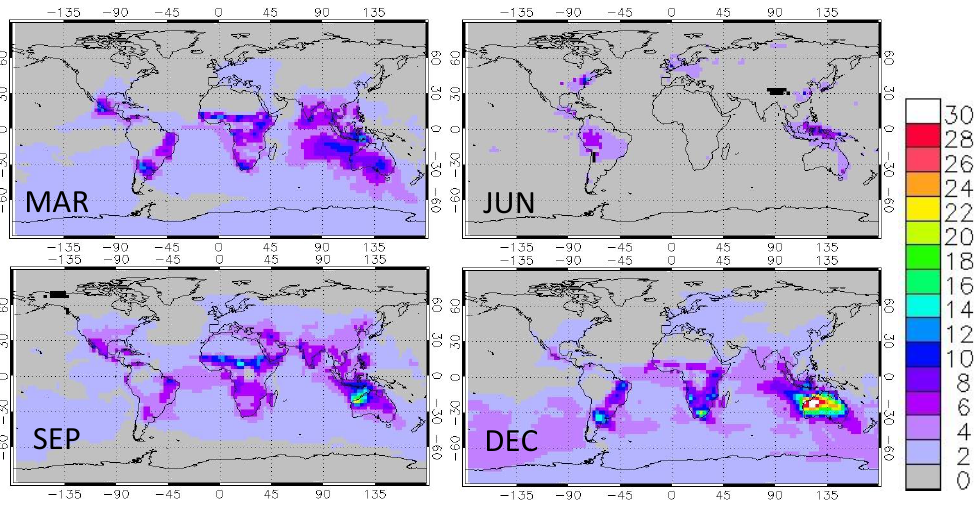
Fig. 4. Fractional change in simulated surface SOA concentrations due to 2p parameter updates and consideration of additional SOA precursors (MZ4-C2) relative to the base-case. Table 3. Regionally averaged annual SOA concentrations at the surface for the year